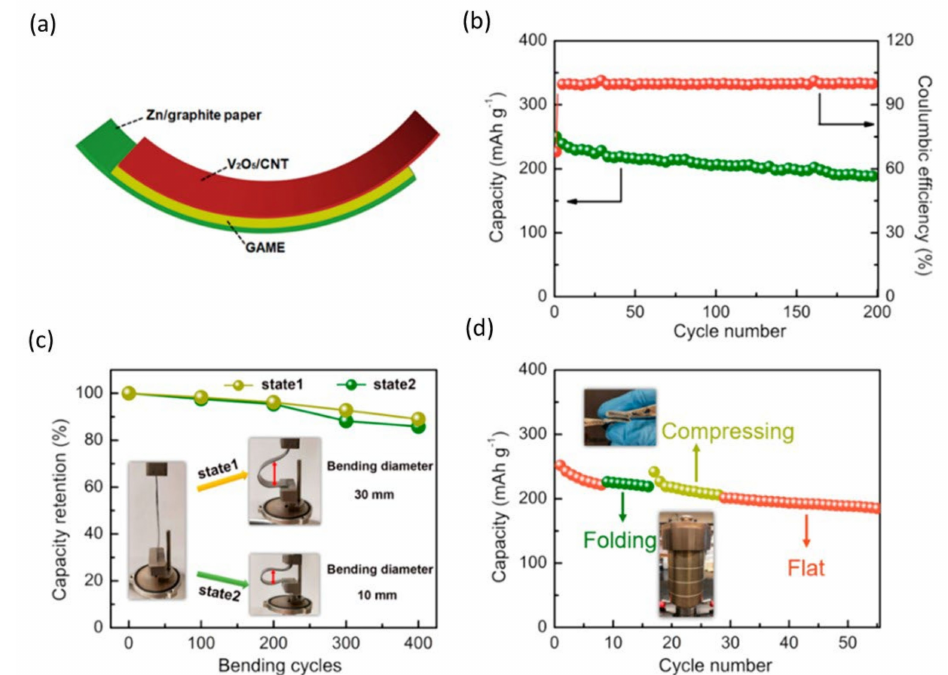
Figure 9. Configuration and performance of a flexible semisolid Zn/V 2 O 5 battery. ( a ) Schematic diagram of a flexible semisolid Zn/V 2 O 5 battery. ( b ) Cyclic performance at 2.0 Ag − 1 . ( c ) Capacity retention vs. bending cycle at 2.0 Ag − 1 . The insets show photographs of the battery under two bending states. ( d ) Cyclic performance under various mechanical stimuli at 2.0 Ag − 1 . Reprinted with permission from Ref. [79]. Copyright 2019 American Chemical Society.